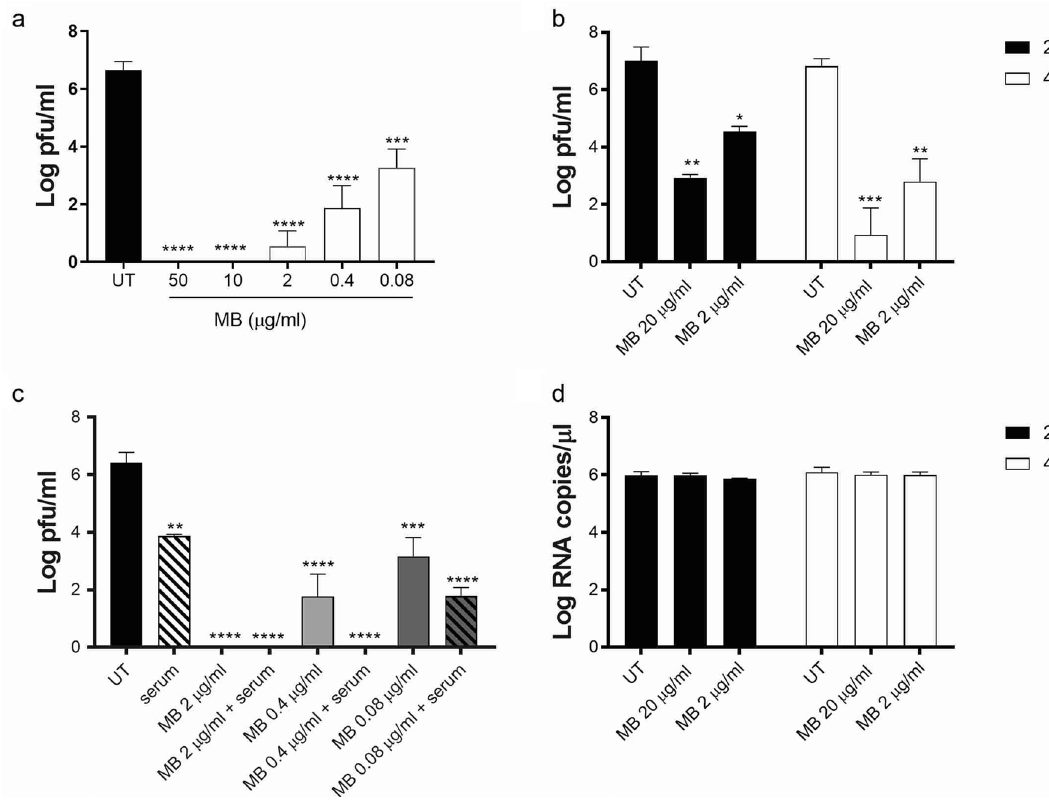
Figure 2. Assessment of MB antiviral activity on SARS-CoV-2. MB was incubated with SARS-CoV-2 (5 × 10 6 pfu) for 20 h ( a , c ) or 2 h and 4 h ( b , d ) in the darkness, in ( c ) MB was incubated in combination with human convalescent serum (diluted 1:80). At the end of the incubation, mixtures were serially diluted and added for 1 h at 37 °C on Vero-E6 cells. Mixtures were then removed and cells were overlaid with medium containing 0.8% avicel. Cells were fixed 48 hpi and plaques were counted in order to determine the viral titer in presence